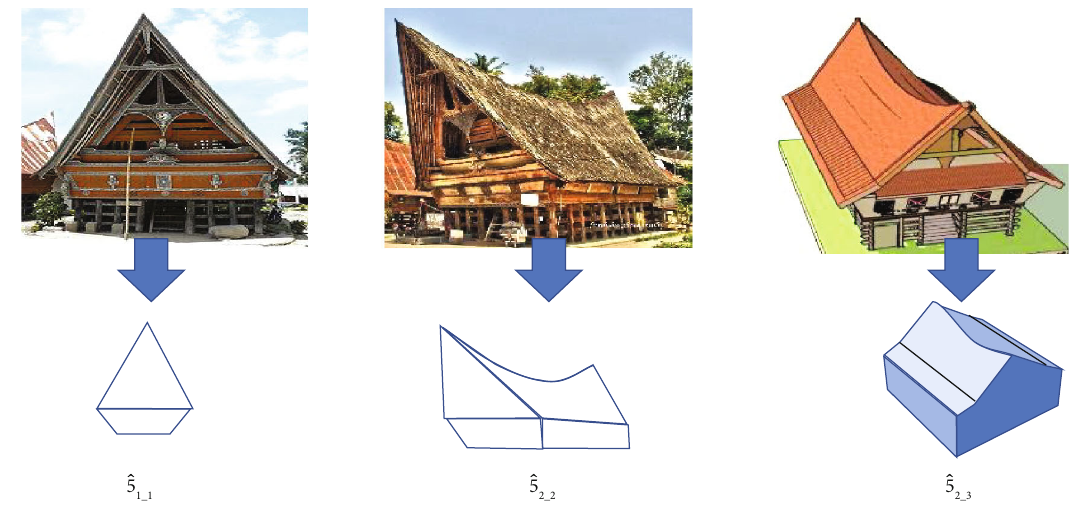
Figure 52: Batak Toba